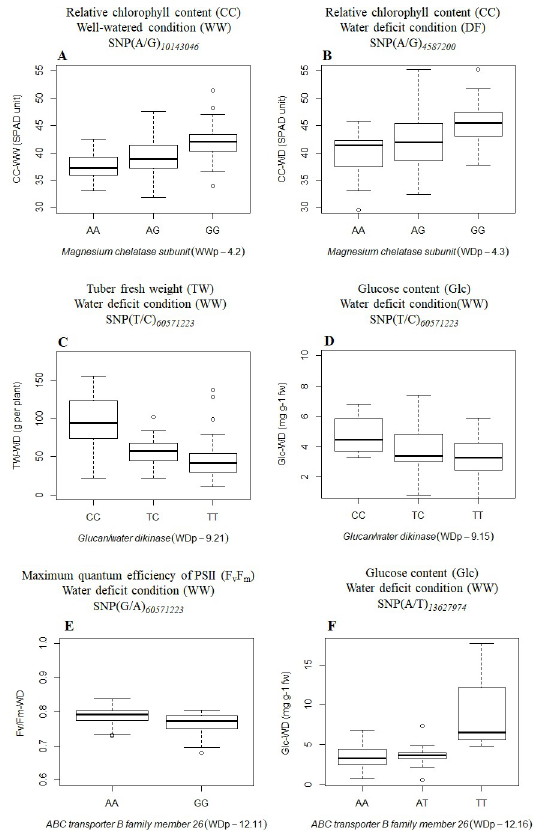
Fig 5. Boxplots showing the allele effects of six significant QTL: a.) relative chlorophyll content (CC)- well-watered condition (WW), b.) relative chlorophyll content (CC)- water deficit condition (WD), c.) tuber fresh weigh per plant (TW)-water deficit condition (WD), d-f.) glucose (Glc)-water deficit condition (WD) and e.) the maximum quantum efficiency of PSII (F v /F m ). Y-axis: values for variables. X-axis: SNP genotypic classes. The gene annotation is presented in